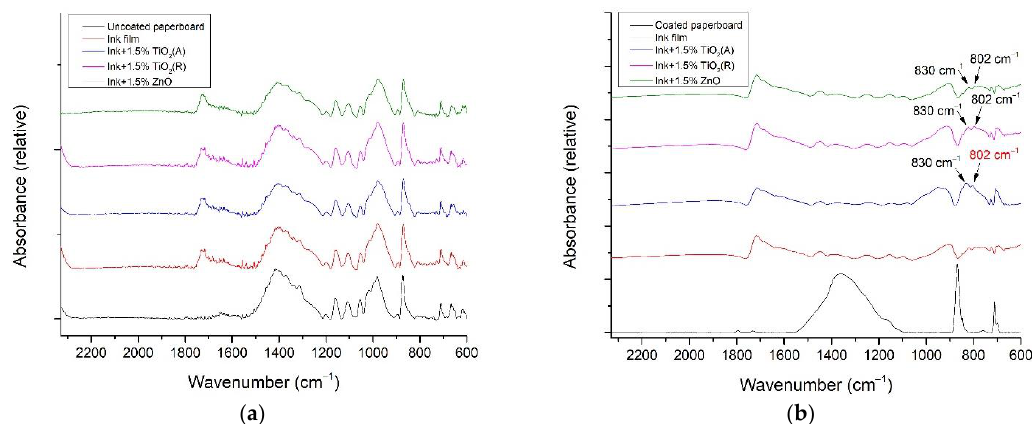
Figure 2. FTIR – ATR spectra of paperboards with deposited ink films and the addition of 1.5% of TiO 2 (A), TiO 2 (R), and ZnO nanoparticles; ( a ) uncoated paperboard and ( b ) coated paperboard.